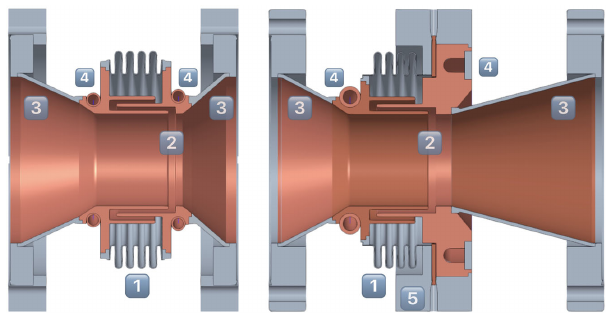
FIG. 2. Cross sections of CSB1 (left, a total length of 160 mm, upstream to the left) and CSB2 (right, 190 mm). Numbers indicate (1) stainless steel bellow, (2) combined shielding and collimating coaxial labyrinth made of OFHC copper, (3) stainless steel taper sections, copper coated, (4) cooling channels, (5) sepa- rating CF flange with copper gasket